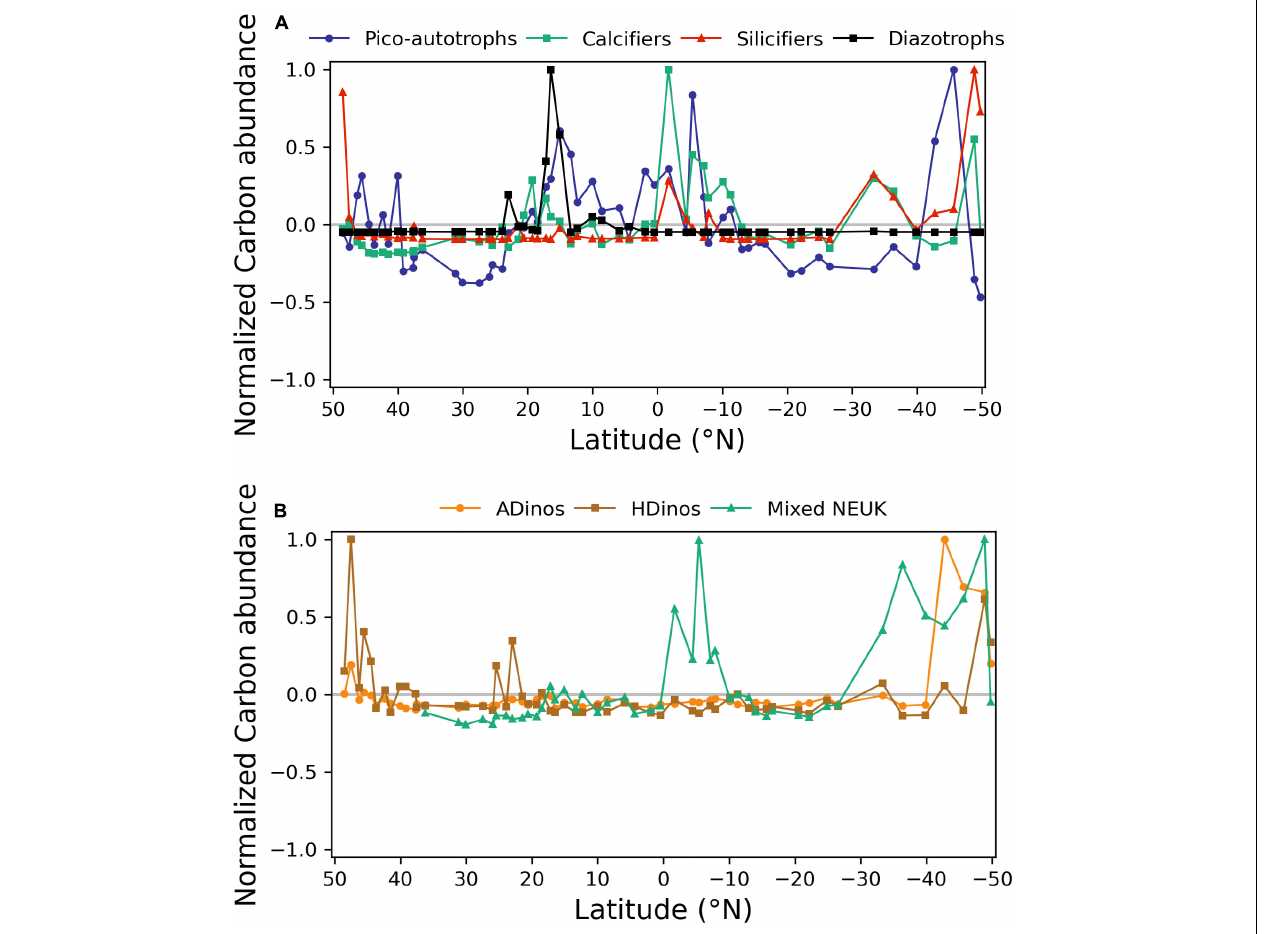
FIGURE 5 | Normalised carbon abundance distribution (mg carbon m − 3 ) of phytoplankton functional types (PFTs) along the transect, determined by FC or microscopy. (A) Picoautotrophs, calcifiers, silicifiers, and diazotrophs; (B) autotrophic dinoflagellates (ADinos), heterotrophic dinoflagellates (HDinos), and mixed nanoeukaryotes (NEUK). Positive and negative anomalies observed for each PFT and normalised to its maximum